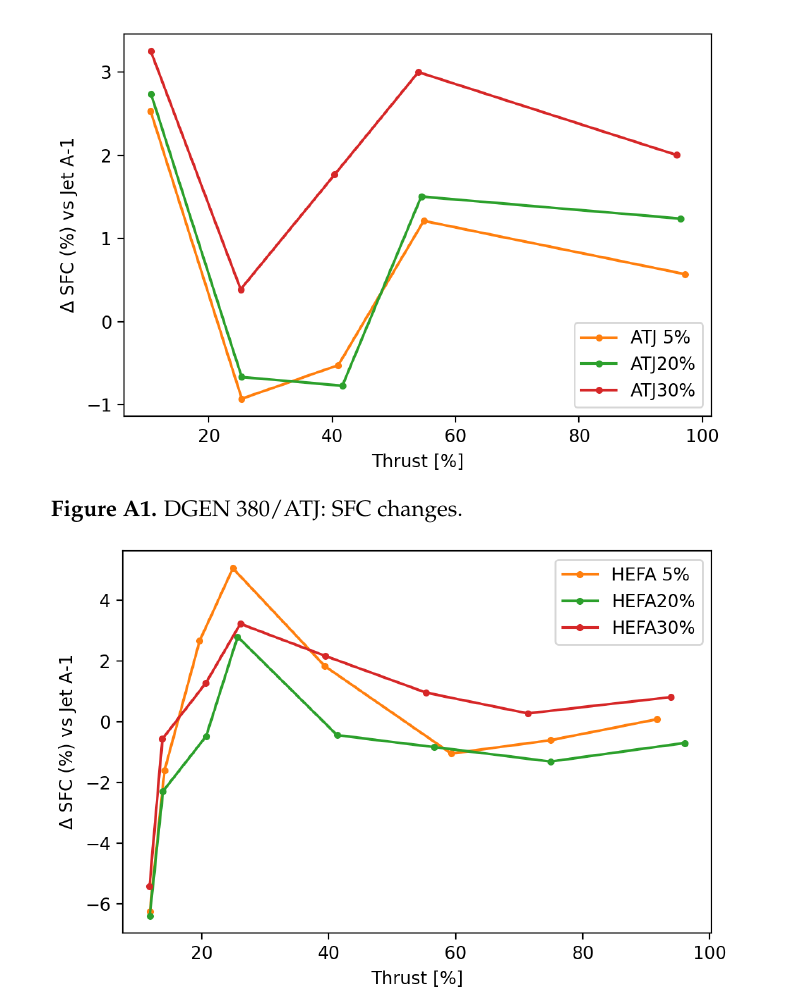
Figure A2. DGEN 380/HEFA: SFC